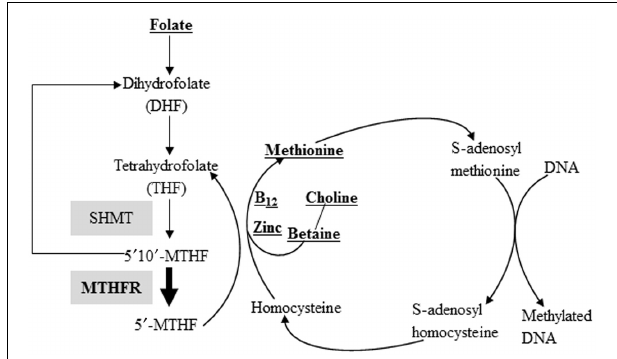
FIGURE 1 | Nutritional methyl-supplements and the DNA methylation reaction. Methyl groups, either synthesized via the folate cycle or donated directly from betaine, are activated by the methyl activation cycle. Activated methyl groups are used to methylate cytosine residues of DNA. Both vitamin B 12 and zinc are cofactors used in the transfer of methyl groups. Compounds listed in bold and underlined are methyl donors or cofactors included in various methyl supplemented diets. Select enzymes involved in this pathway, including MTHFR, where single nucleotide polymorphisms (SNP) variant genotypes have been documented (as detailed in the manuscript) are